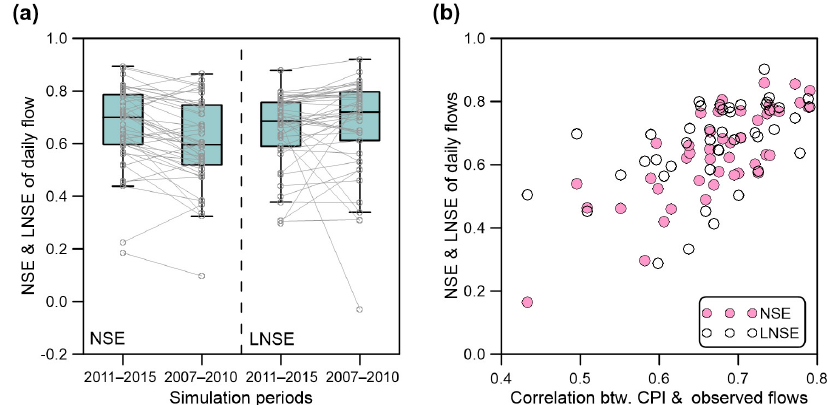
Figure 3. (a) Box plots of high flow (NSE) and low flow (LNSE) reproducibility of the behavioural parameters obtained from the hydrograph calibration at the 45 catchments. (b) The relationship between the input–output consistency and the model performance. The straight lines in the box plots connect the performance metrics for the calibration (2011–2015) and the validation periods (2007–2010) in each